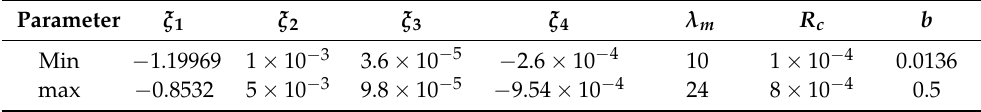
Table 1. Parameter range of the PEMFC.